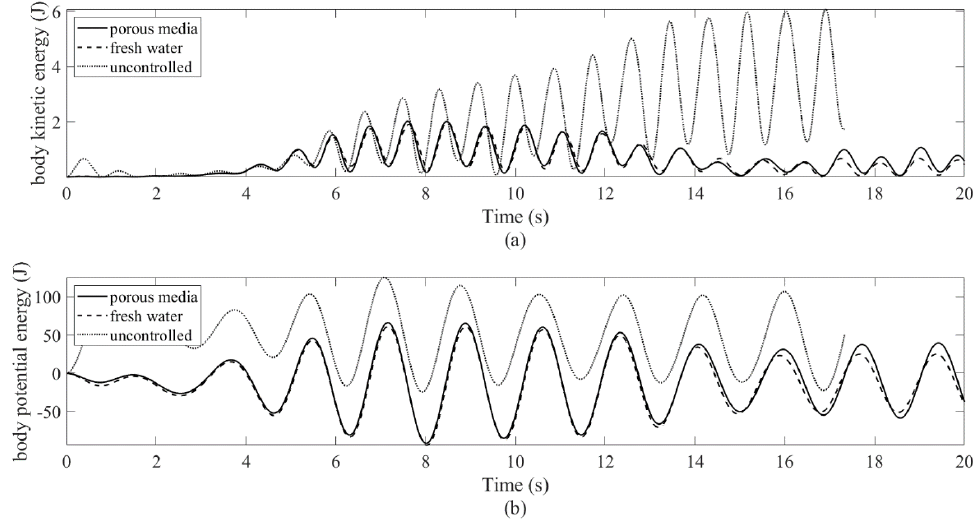
Figure 30. The energy changes of the floating body: ( a ) kinetic energy; ( b ) potential energy. The kinetic and potential energy changes of the sloshing fluid are shown in Figure 31. For the first 15 s in Figure 31a, the kinetic energy of the sloshing fluid without porous media increased faster than that with porous media. This shows the porous media can quickly dampen the kinetic energy in the transient state, therefore suppressing the fluid velocity and the free-surface deformation. By correlating the force/moment and energy change as shown in Figures 24, 28, 30 and 31, the effect of porous media on the FSI can be characterized. When the incident waves hit the floating body, the work is transferred to the body’s kinetic energy. Through the force cancellation, part of the wave-induced work will be taken by the sloshing fluid, and then dissipated by the damping mechanism of the porous media. Therefore, good force cancellation and enough sloshing damping are two key factors for structural vibration control. In Figure 31b, the potential energy of the fluid in the tank without porous media grew higher than that of the fluid in the porous media. Since they had similar elevations, the difference in the potential energy came from differ- ent free-surface deformations.